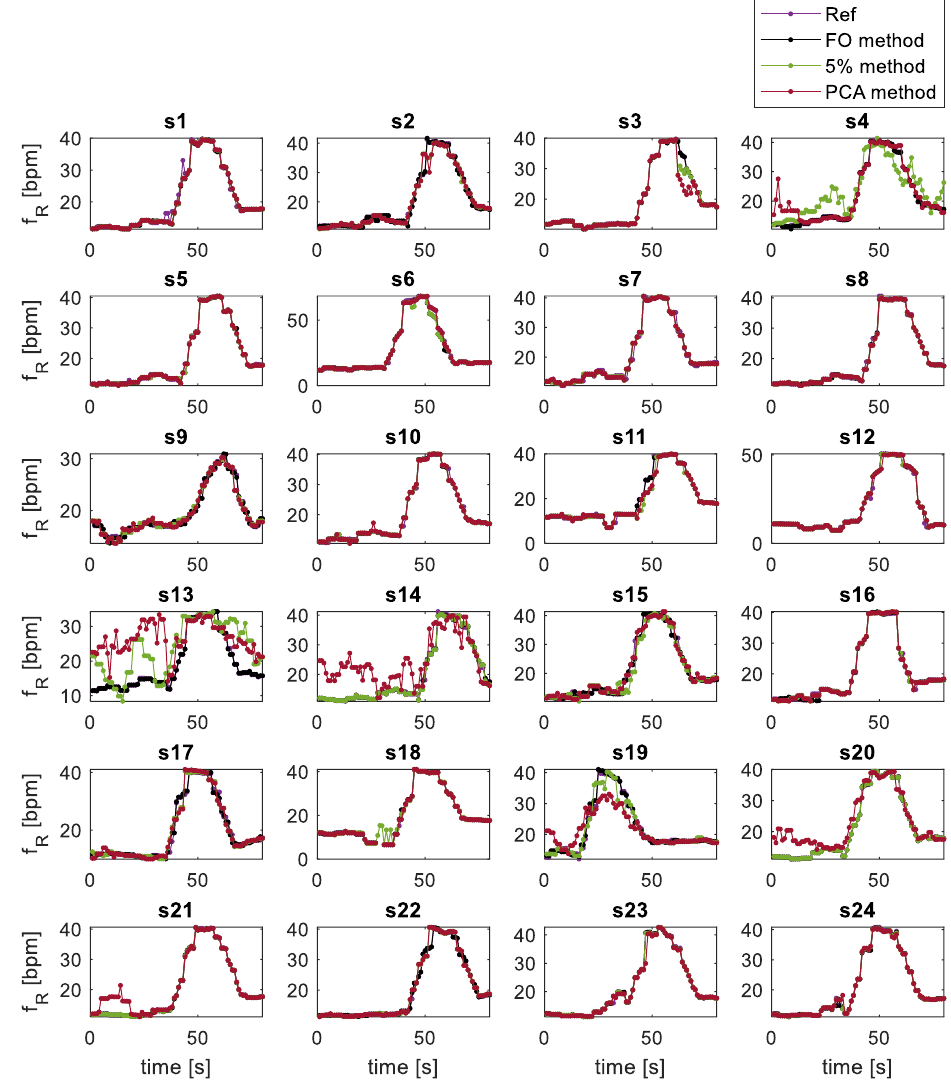
Figure 6. Trend of f R expressed in bpm extracted every second with the optical flow method (in black), 5% method (in green), PCA method (in red) and with the reference (in purple) on all subjects for the first 90 s of the 2-sit